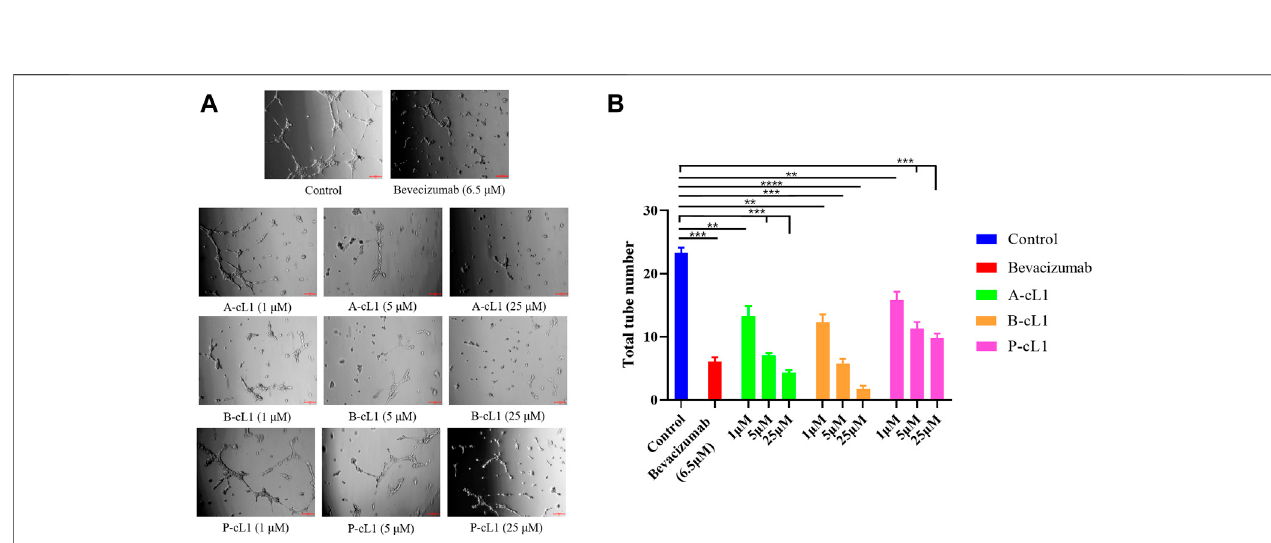
FIGURE 5 | A-cL1, B-cL1, and P-cL1 inhibit VEGF-A stimulated tube formation in HUVECs. (A) Representative images of the capillary tube formation assay. After seeded on Matrigel ® HUVECs were cultured in 2% serum medium containing 0.2 μ g/ml VEGF-A, treated with serum-free medium (control group), or with bevacizumab (positivecontrol),orwith1 μ M,5and25 μ MofA-cL1,B-cL1orP-cL1.Imagesweretakenafter6 htreatment. (B) Quantitativeanalysisofthetubeformationbycounting the capillary number. Data are presented as mean ± SEM of three experiments, statistics analysis using GraphPad Prism 8, compared to the control group in one- way ANOVA. *** p < 0.001, **** p < 0.0001.